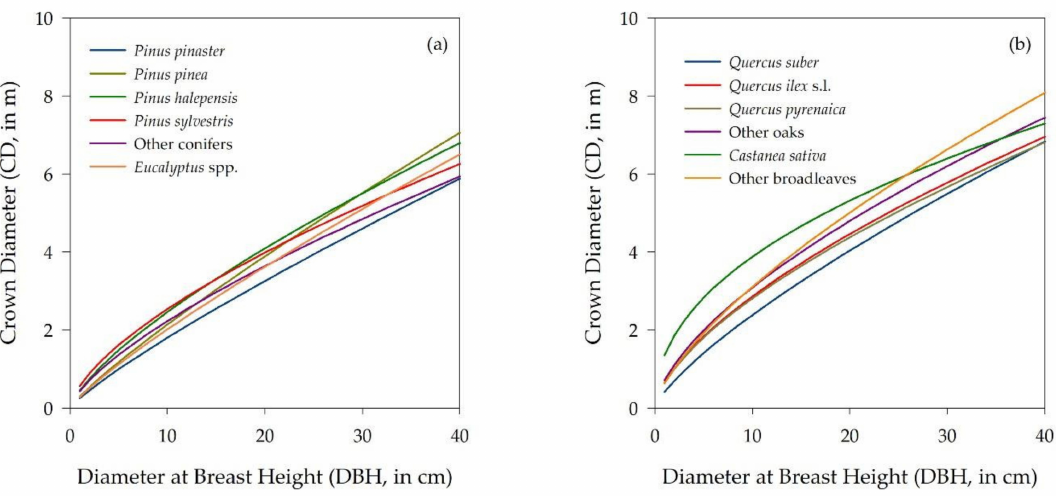
Figure 9. Crown diameter (CD) as a function of Diameter at Breast Height (DBH) for a reference distance (DIST) of 5 m: conifers and eucalypts ( a ), and oaks and other broadleaves ( b ).